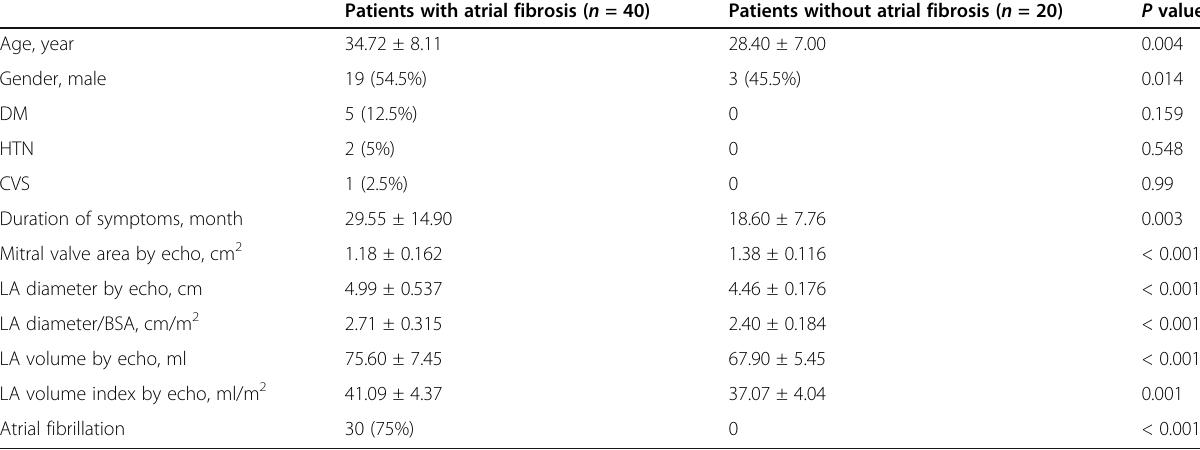
Table 3 Comparison between patients with atrial fibrosis and those without atrial fibrosis Patients with atrial fibrosis ( n = 40) Patients without atrial fibrosis ( n = 20)